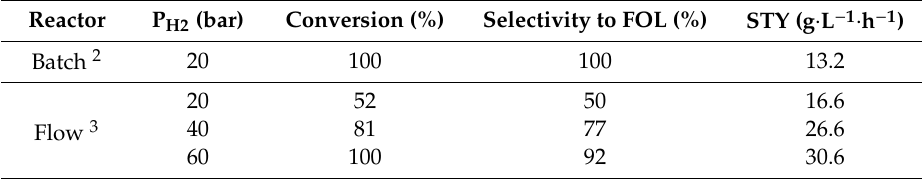
Table 3. Hydrogenation of furfural: effect of the reactor 1 .